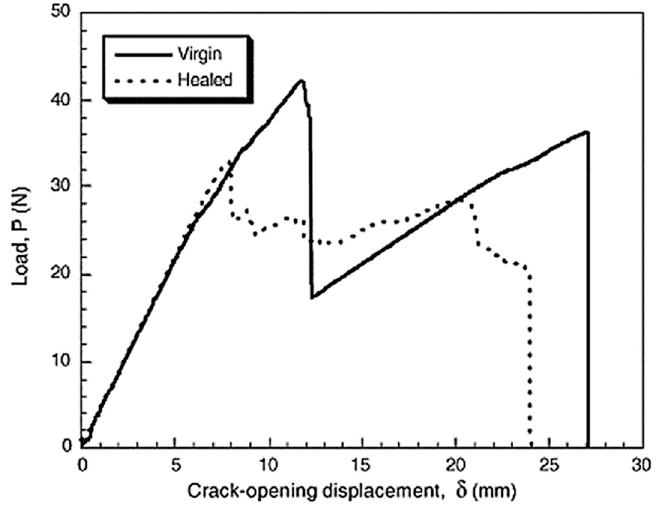
Figure 12. Typical loading curves of pristine and healed self-healing samples (note: healing condi- tions = 48 h at 80 °C). Reprinted with permission from [130]. 2003, Elsevier.